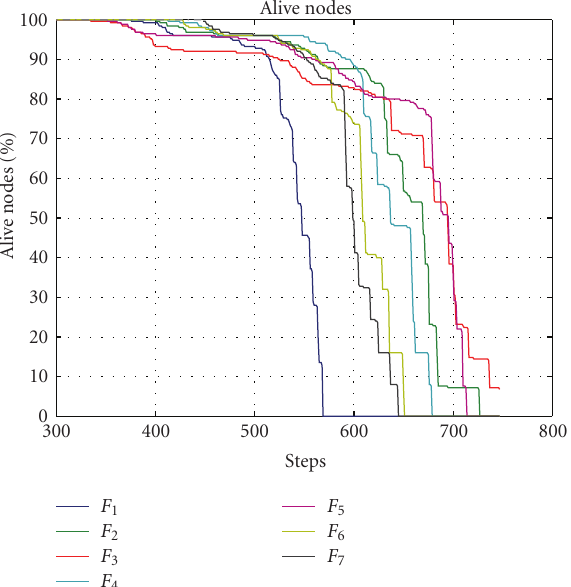
Figure 11: Number of single-hop connections in the considered network during iterations for di ff erent criteria, defined in Table 2 (average results over 10